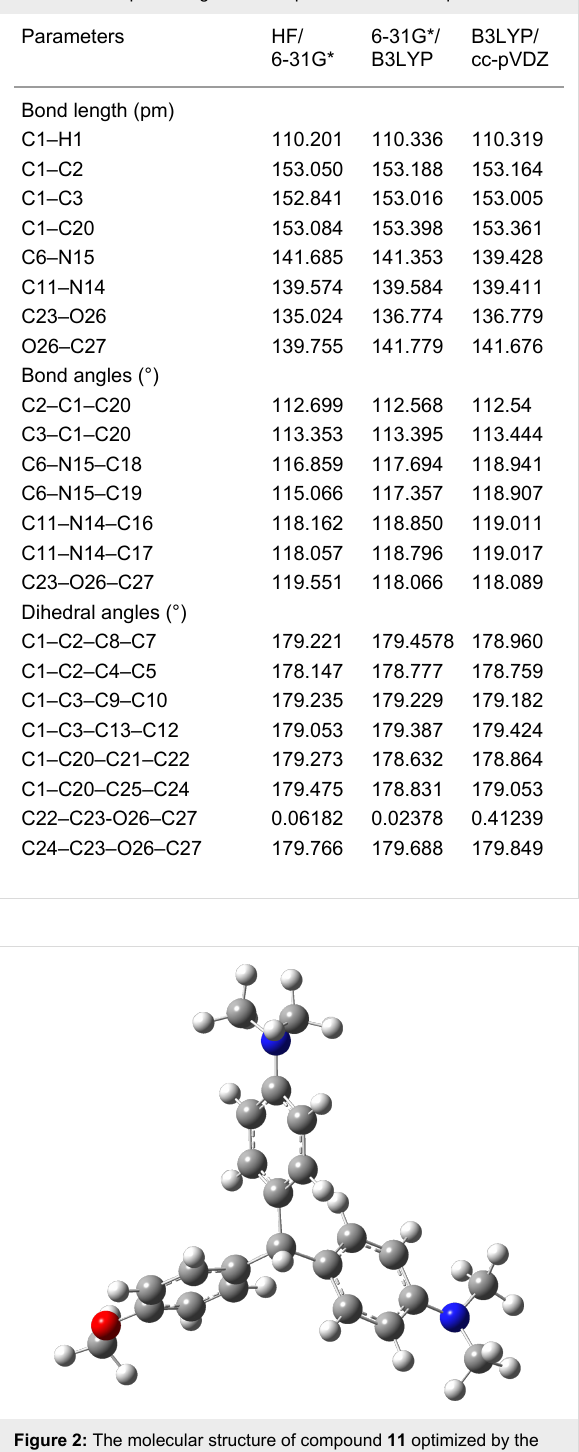
Table 2: The optimized geometrical parameters for compound 11 .